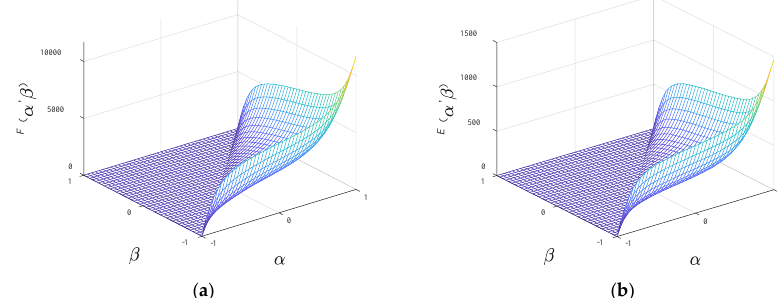
Figure 7. Normalized inverted scalar Everett function F and vector Everett function E : ( a ) Function F ; ( b ) Function E .